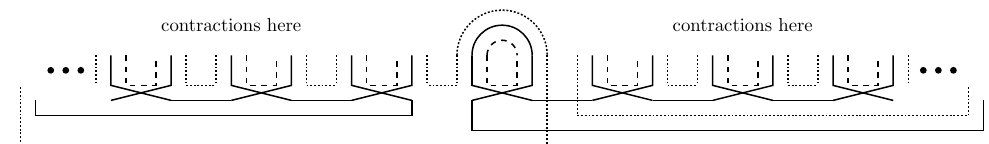
Figure 44 . The representation of the mixed trace term in the diagrammatic notation. Dotted lines represent system A , solid lines stand for system B , and dashed lines are for system C .